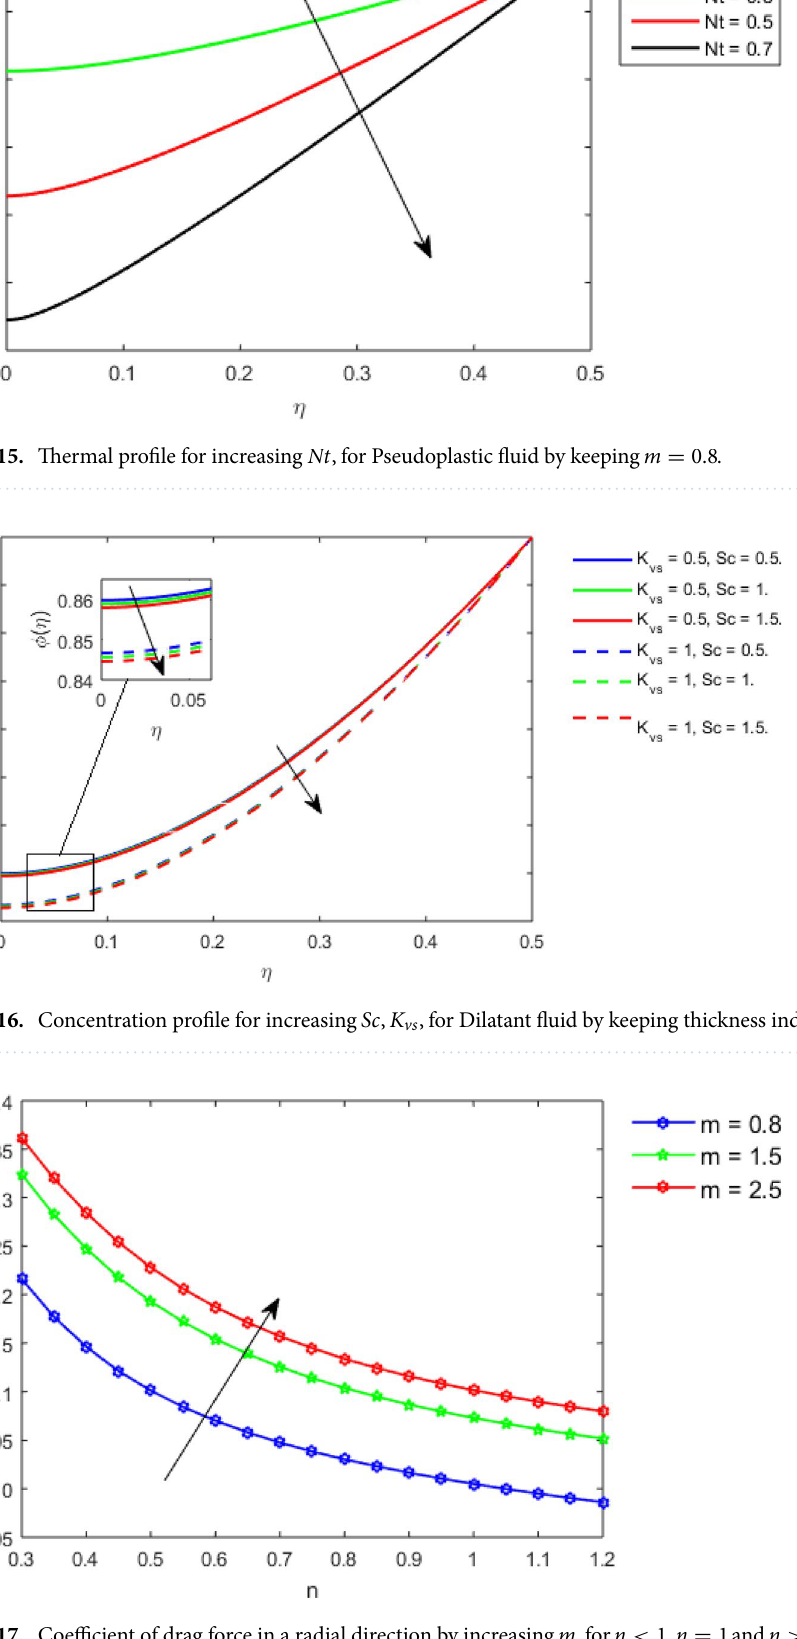
Figure 17. Coefficient of drag force in a radial direction by increasing m , for n < 1, n = 1 and n > 1